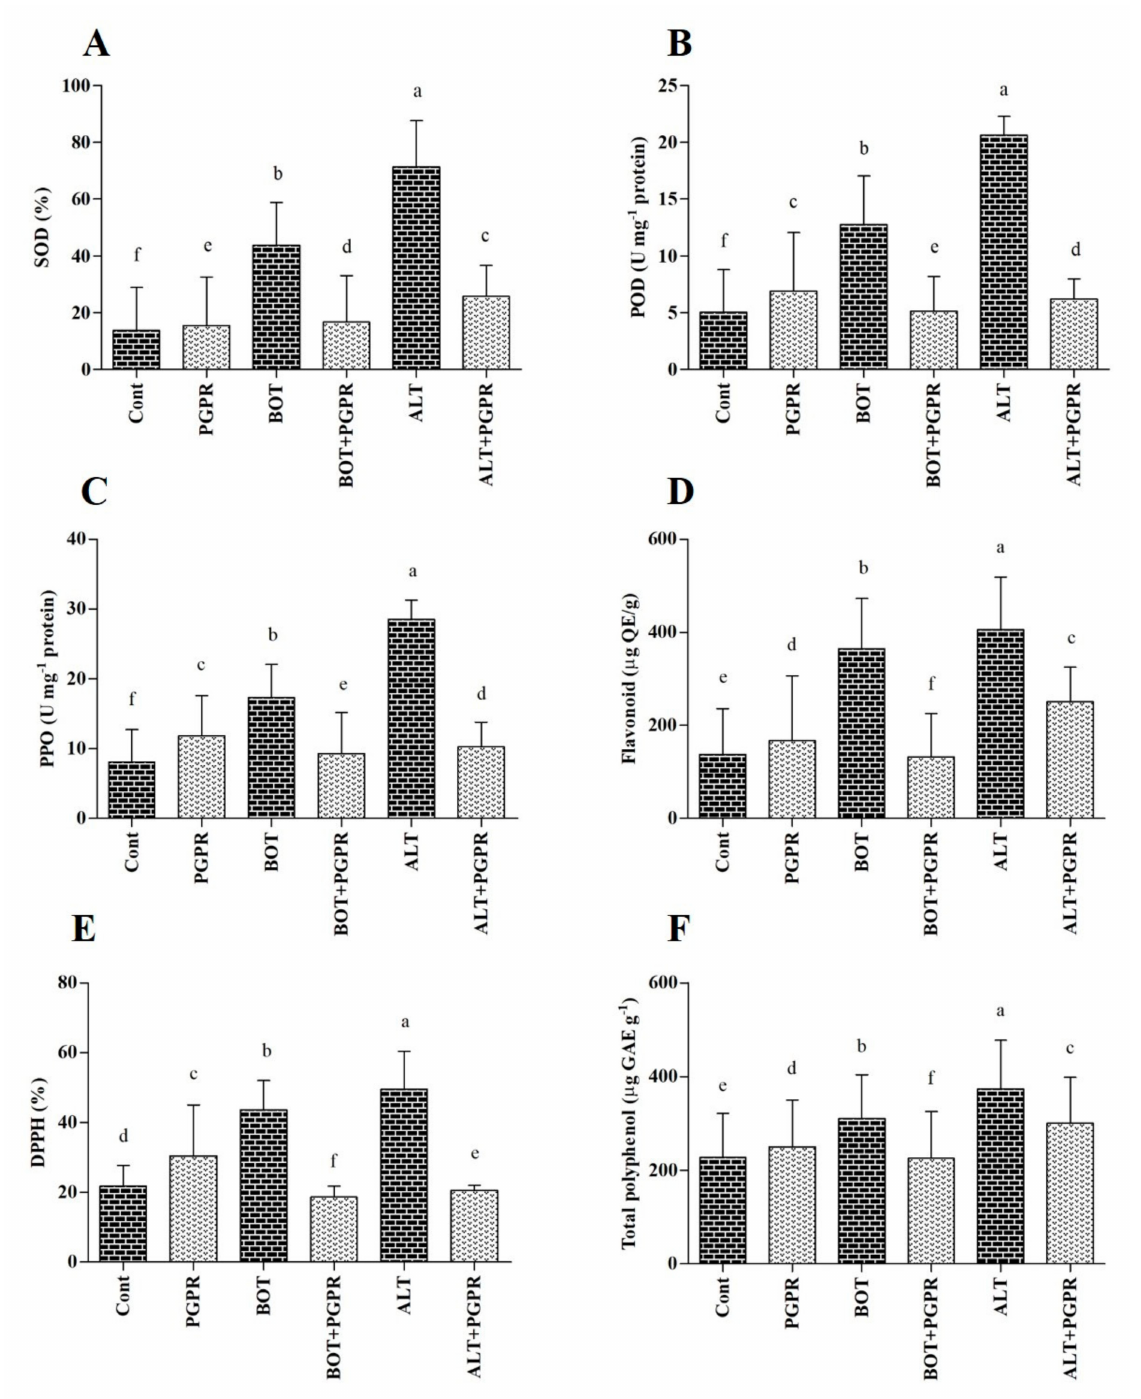
Figure 8. Antioxidant contents (( A ), SOD; ( B ), peroxidase; ( C ), polyphenol oxidase; ( D ), flavonoid; ( E ), DPPH; ( F ), total polyphenol) in leaves of peppers grown under normal and stress conditions and treated with plant growth-promoting rhizobacteria (PGPR) after eight days. Treatment: Cont (control), PGPR ( Bacillus amyloliquefaciens ), BOT ( Botrytis pelargonii ), PGPR + BOT ( Bacillus amyloliquefaciens + Botrytis pelargonii ), ALT ( Alternaria alternata ), PGPR + ALT ( Bacillus amyloliquefaciens + Alternaria alternata ). Values show the means ± standard error ( n = 3) and significant differences are indicated at p < 0.05 in accordance with the least significant difference test. Bars with different letters are significantly different from each